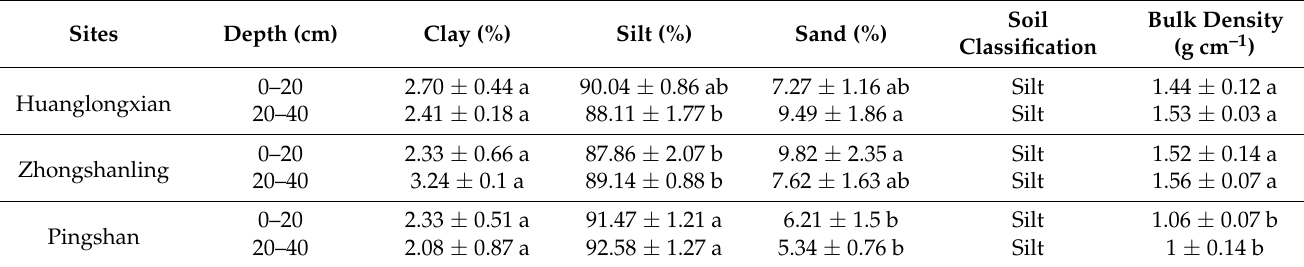
Table 1. Soil physical properties in the three sampling sites.